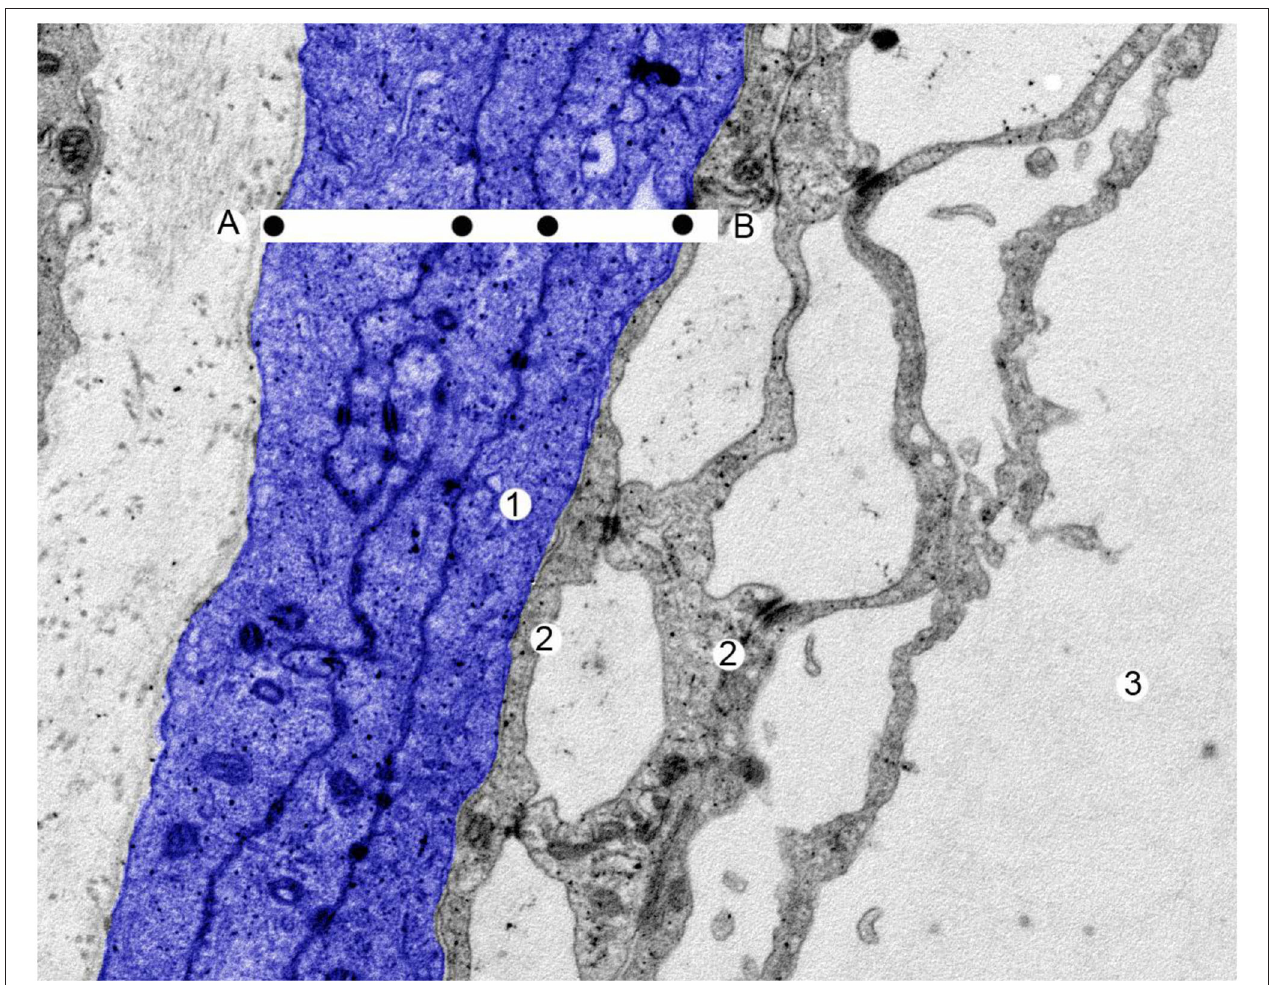
FIGURE 3 | A human arachnoid layer. Scanning electron microscopy. Magnification x 25,000. The entire thickness of the arachnoid layer in blue. 1 = arachnoid cell, 2 = arachnoid trabeculate, 3 = cerebrospinal fluid. The drugs diffuse through the arachnoid layer from (A) to (B) . The black dots mark the plasmatic membrane of arachnoid cells where the molecules are lipid resistant. With permission of Dr. Miguel A.